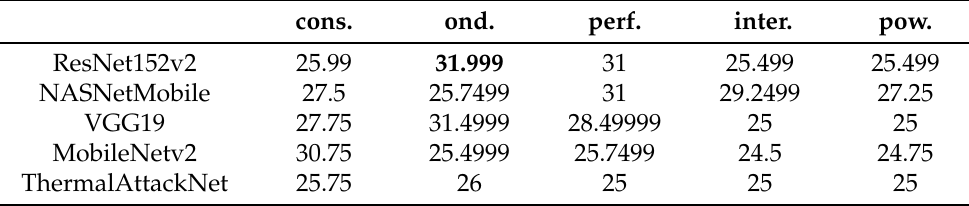
Table 3. Testing prediction accuracy (%) achieved by different CNNs on different Linux governors: conservative (cons.), ondemand (ond.), performance (perf.). cons. ond.